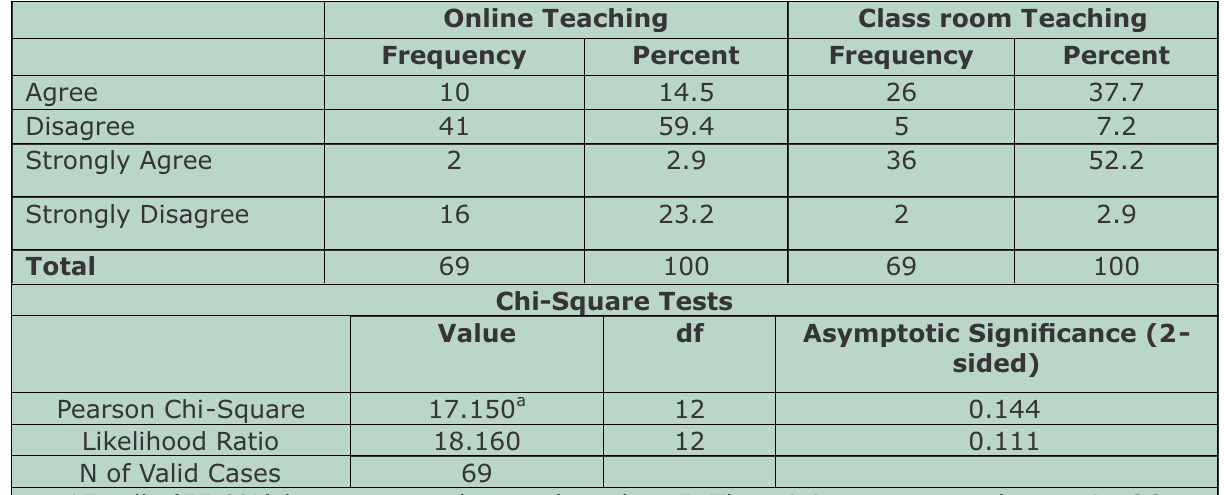
Figure-II: Comparison of Online Teaching vs Class Room Teaching. Table-II: Comparison of Online vs Class room teaching more interactive